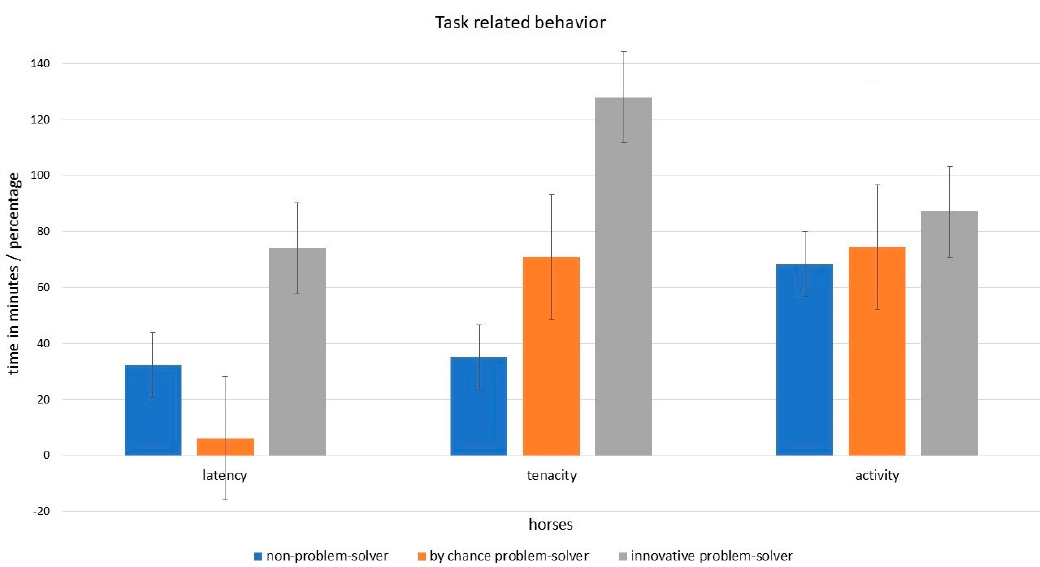
Figure 4. Task related behavior of the test horses. The activity is calculated from the animal’s level of being in motion. As the activity covers a longer lapse of time, the minutes were divided by 10 to be graphically comparable to the other behaviors in this figure. The animals’ latency is calculated from the duration until first contact with the feeder. The duration of time spent with the feeder is the ratio from the time spent with the feeder to the active time. Therefore, the time effort is given as a percentage. The bars indicating the standard errors.